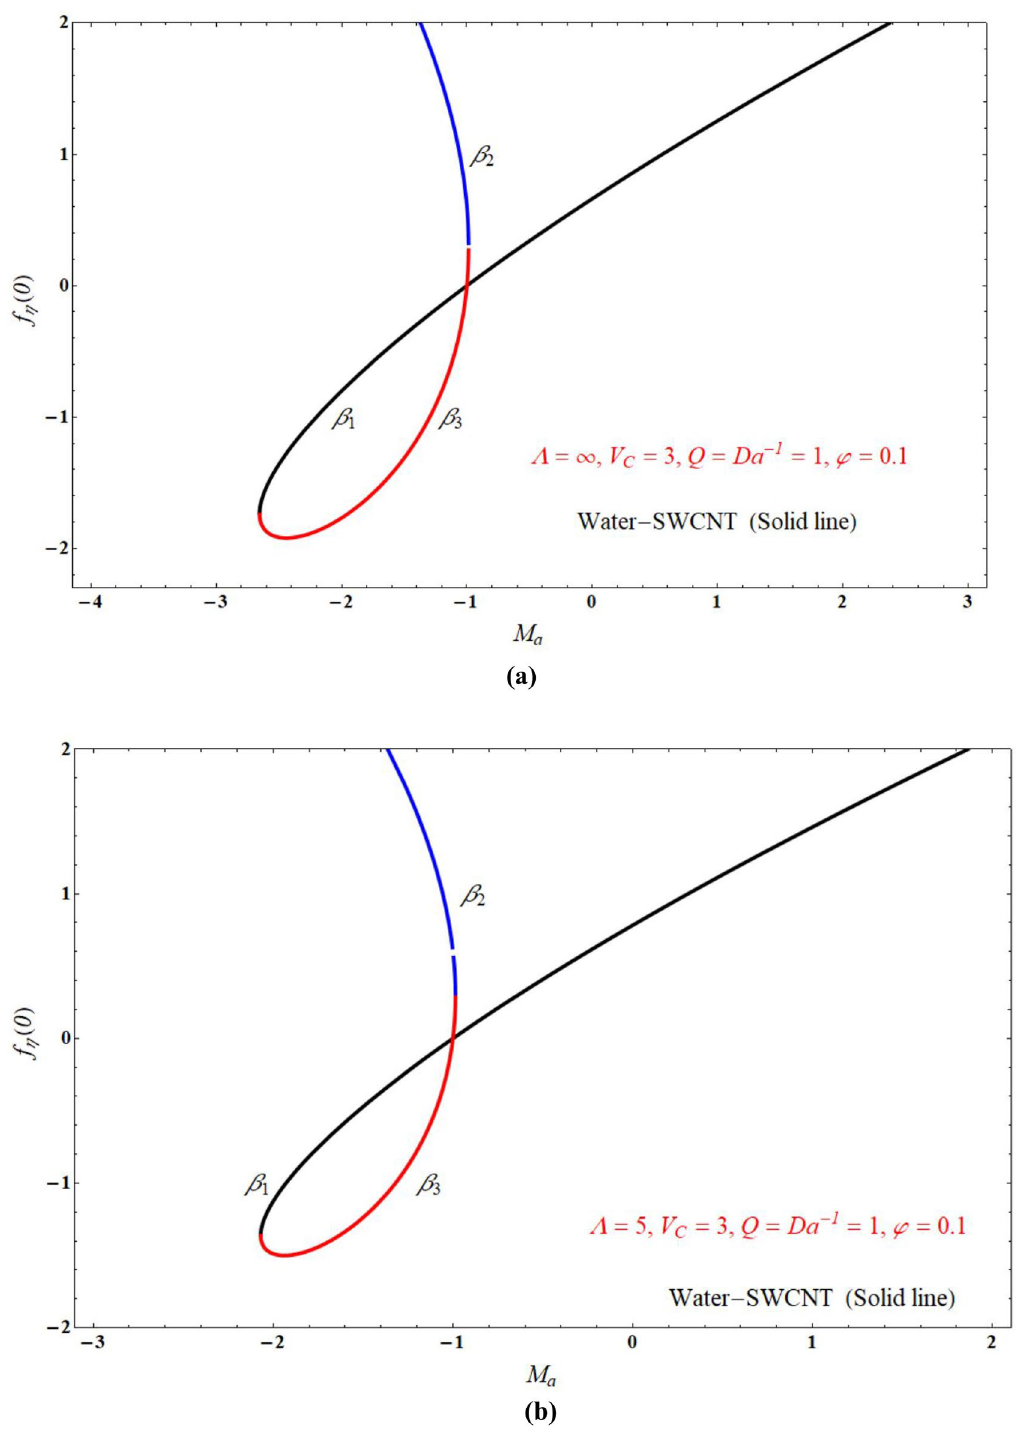
Figure 4. The plots of f η ( 0 ) verses Ma at (a) (cid:31) = ∞ , and (b) (cid:31) = 5